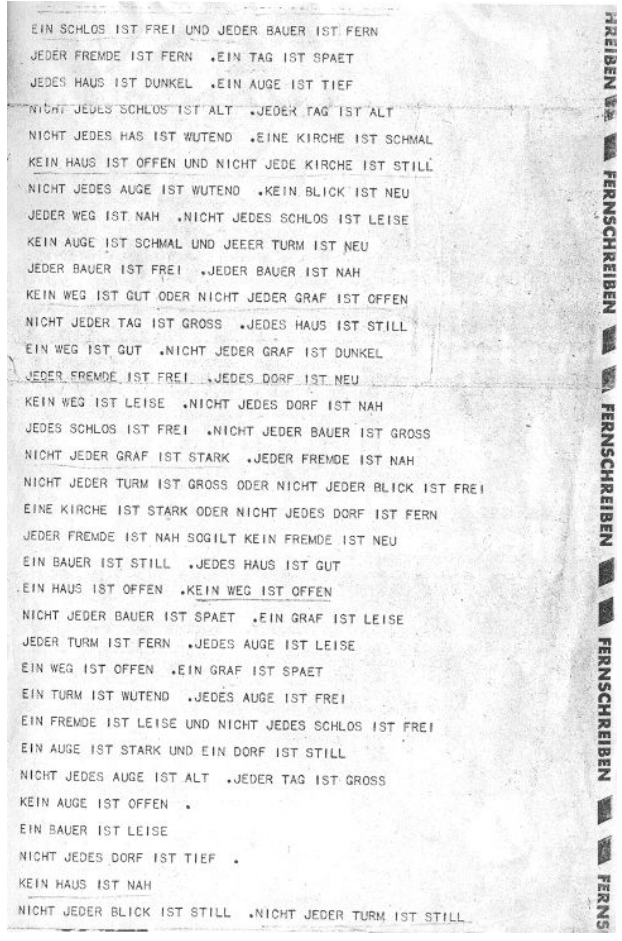
Figure 4. Pedro Barbosa. Porto, 1977.